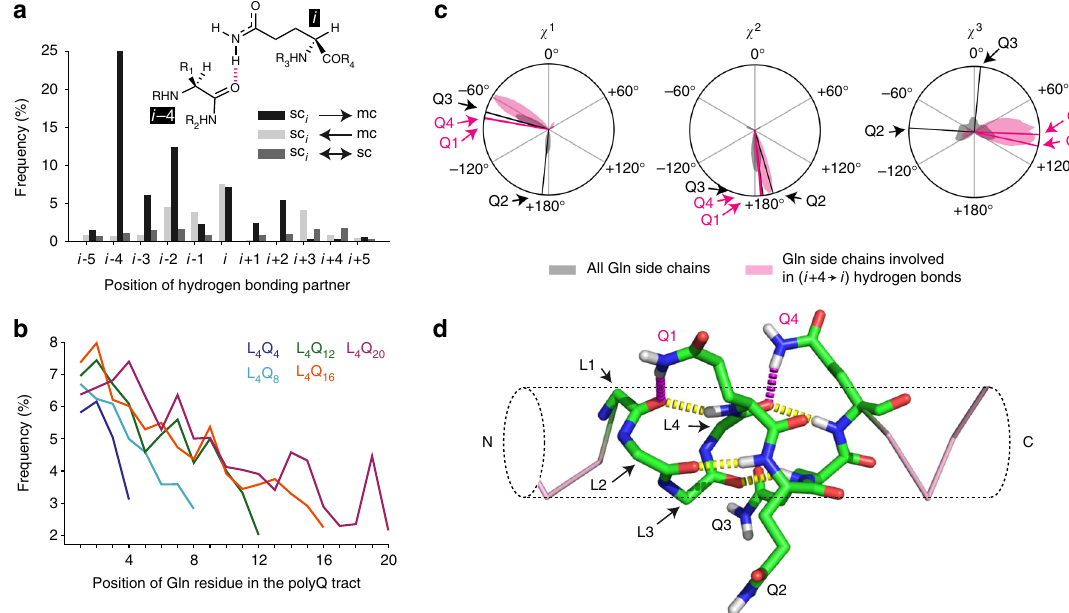
Fig. 4 The structures of polyQ helices feature sc( i ) → mc( i − 4) hydrogen bonds. a Frequencies of the various types of hydrogen bonds involving Gln side chains in the aggregated reweighted trajectories. b Frequencies of sc( i ) → mc( i − 4) hydrogen bonds in the reweighted ensembles obtained for peptides L 4 Q 4 to L 4 Q 20 as a function of the position of the corresponding residue in the tract. c Distributions of the χ 1 , χ 2 , and χ 3 dihedral angles of Gln side chains and of the subset of those side chains involved in sc( i ) → mc( i − 4) hydrogen bonds with an illustration of the values of the four side chains highlighted in d . d Frame of the trajectory obtained for L 4 Q 16 where residues Q1 and Q4 (in purple), but not Q2 and Q3 (in black), are involved in sc( i ) → mc( i − 4) hydrogen bonds with the CO groups of residues L1 and L4, shown in purple, with an indication of the conventional mc( i ) → mc( i − 4) hydrogen bonds, shown in yellow. The Leu side chains are not shown, for